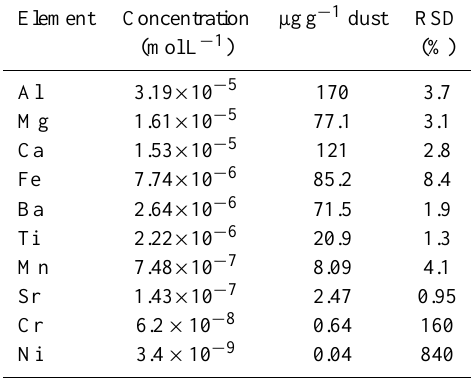
Table 3. The concentrations of various elements present in Sahara dust leachate measured with ICP-OES. “Concentration” refers to the solution used to oxidise SO 2 in this study, which was made with 0.5g of dust per 100ml of water, while “µgg − 1 dust” is the amount of the element that is soluble in 1g of dust following 2days in MilliQ water. “RSD” is the relative standard deviation of 3 mea- surements from the